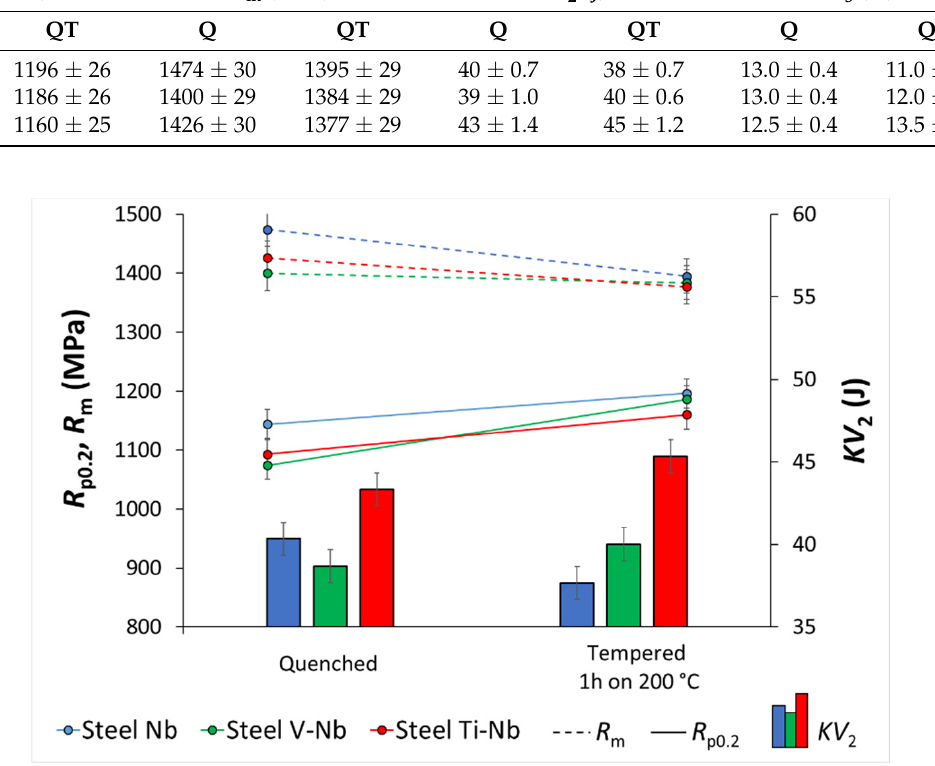
Figure 7. Yield strength ( R p0.2 ), tensile strength ( R m ), and impact toughness at − 40 °C ( KV 2 ) for steel Nb, V–Nb, and Ti–Nb in quenched and tempered condition.